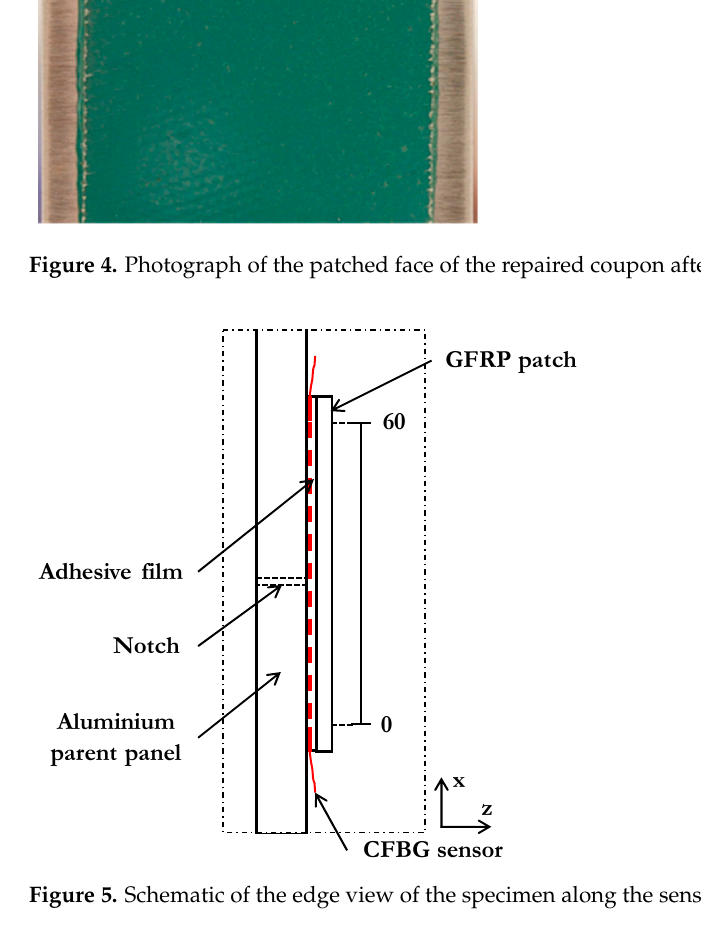
Figure 5. Schematic of the edge view of the specimen along the sensor line (not to scale).